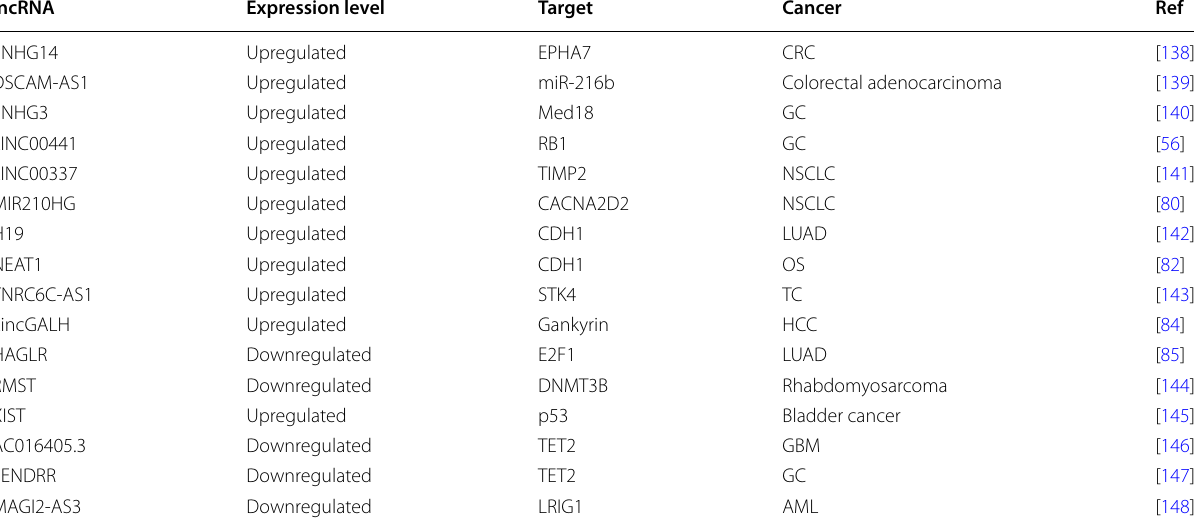
Table 3 Effect of lncRNA on DNA methylation